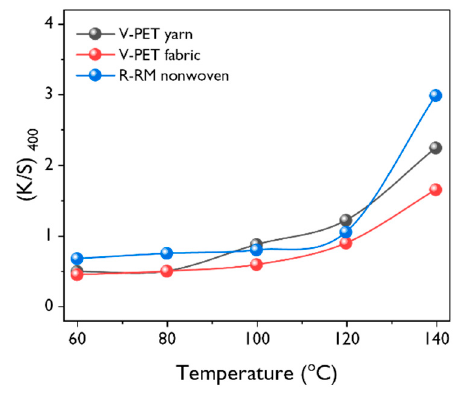
Figure 6. Effect of the dyeing temperature on the K/S value measured at 400 nm (dye concentration = 10 %owf; dyeing time = 60 min; liquor ratio = 1:50).